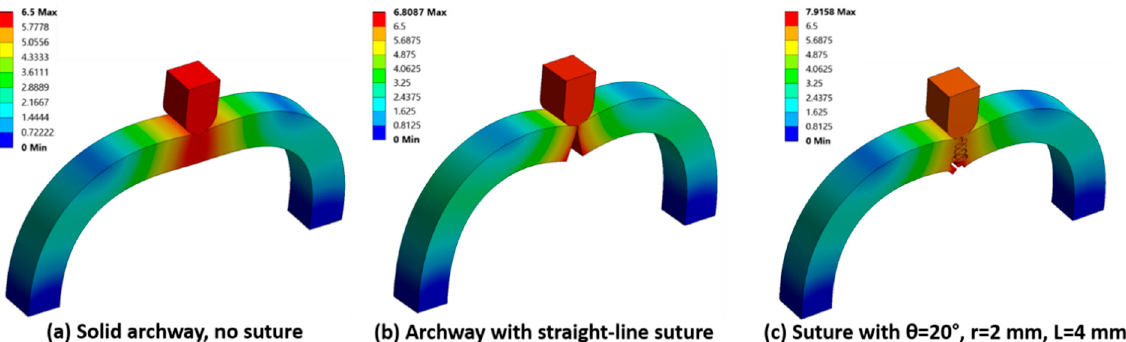
Figure 8. Total deformation (in mm) of the two base cases: ( a ) solid archway with no suture; ( b ) archway with a straight-line suture; and ( c ) one representative case with a dovetail suture. A scale factor of 3 was used to exaggerate the deformed shape. The maximum deformation in ( b , c ) exceeded the applied indenter displacement of 6.5 mm.